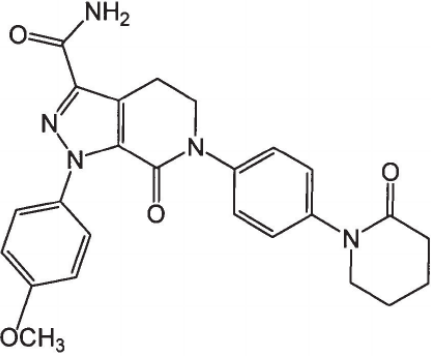
Figure 1. Chemical structure of APX.